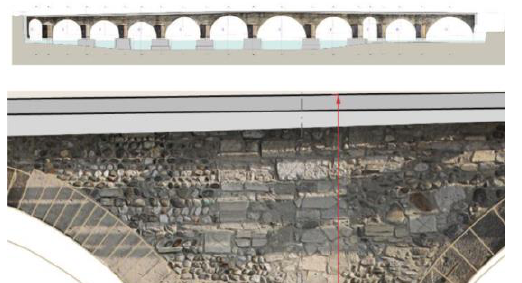
Figure 6: Orthophoto of the elevations of Azzone Visconti bridge. (Banfi et al. , 2017)